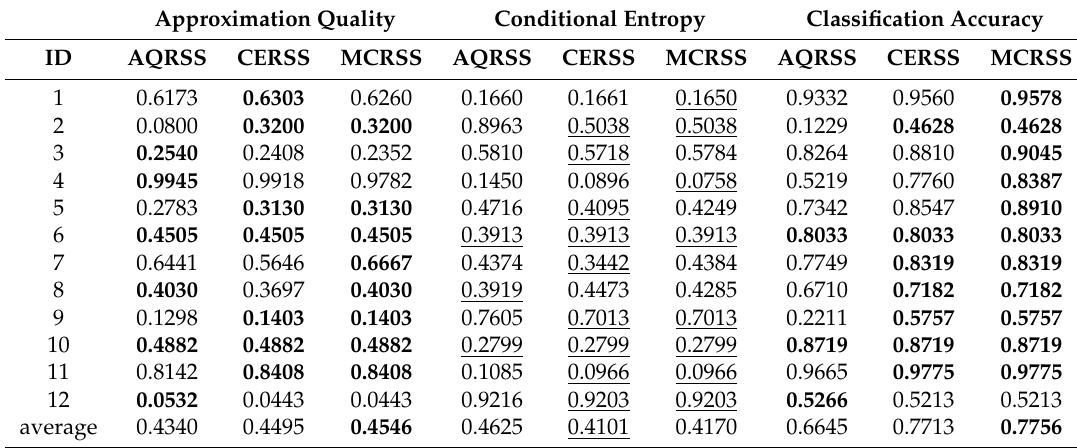
Table 4. Results obtained by using core